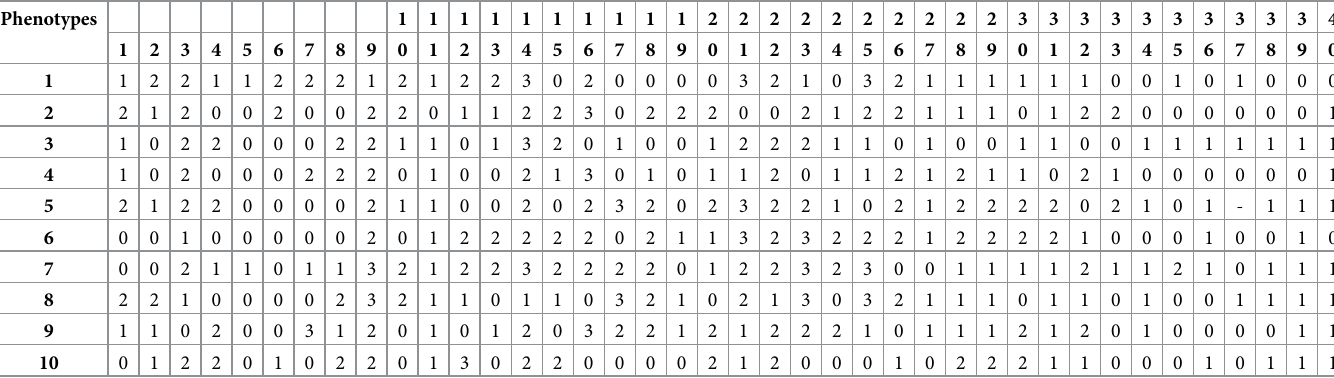
Table 3. Matrix data of morphological character states for Saudi E . orientalis populations.